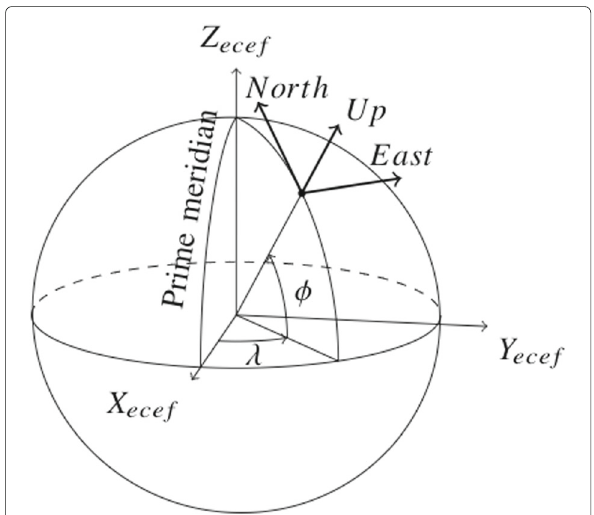
Fig. 22 Comparison of Earth-Centered Earth-Fixed (ECEF), East-North-Up (ENU) and geodetic coordinate systems coordinates. The origin of ECEF coordinate system is located in the center of Earth, and the axes are defined in following form: [36] • Z-axis is along the spin axis of the Earth, pointing